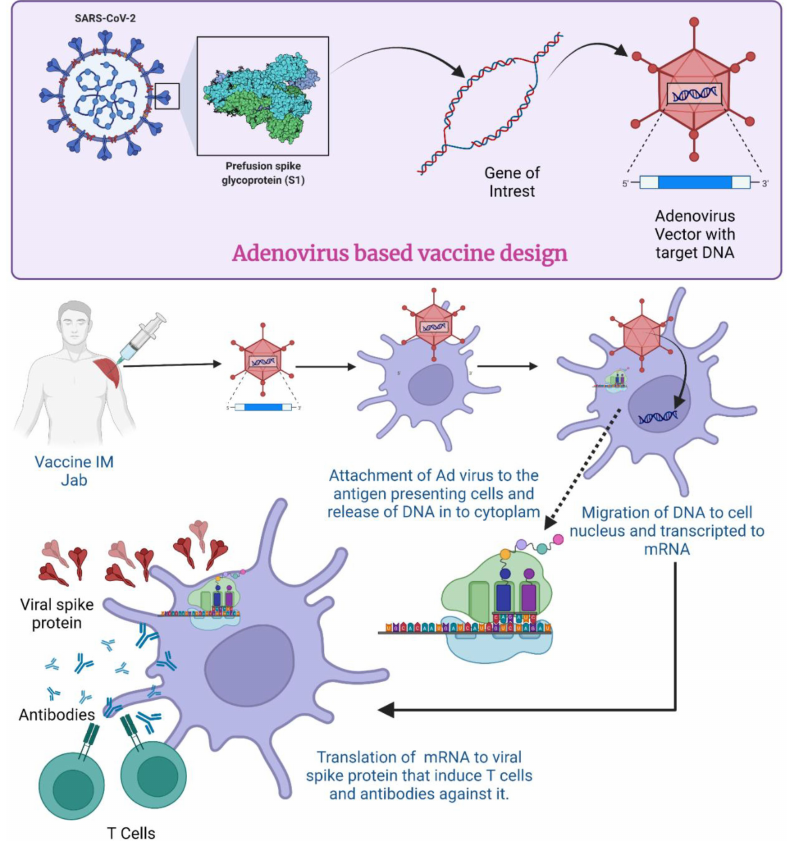
Figure 4. Mechanism of Adenovirus vector-based vaccine for COVID-19. (Created using Biorender.com), accessed on 19 December